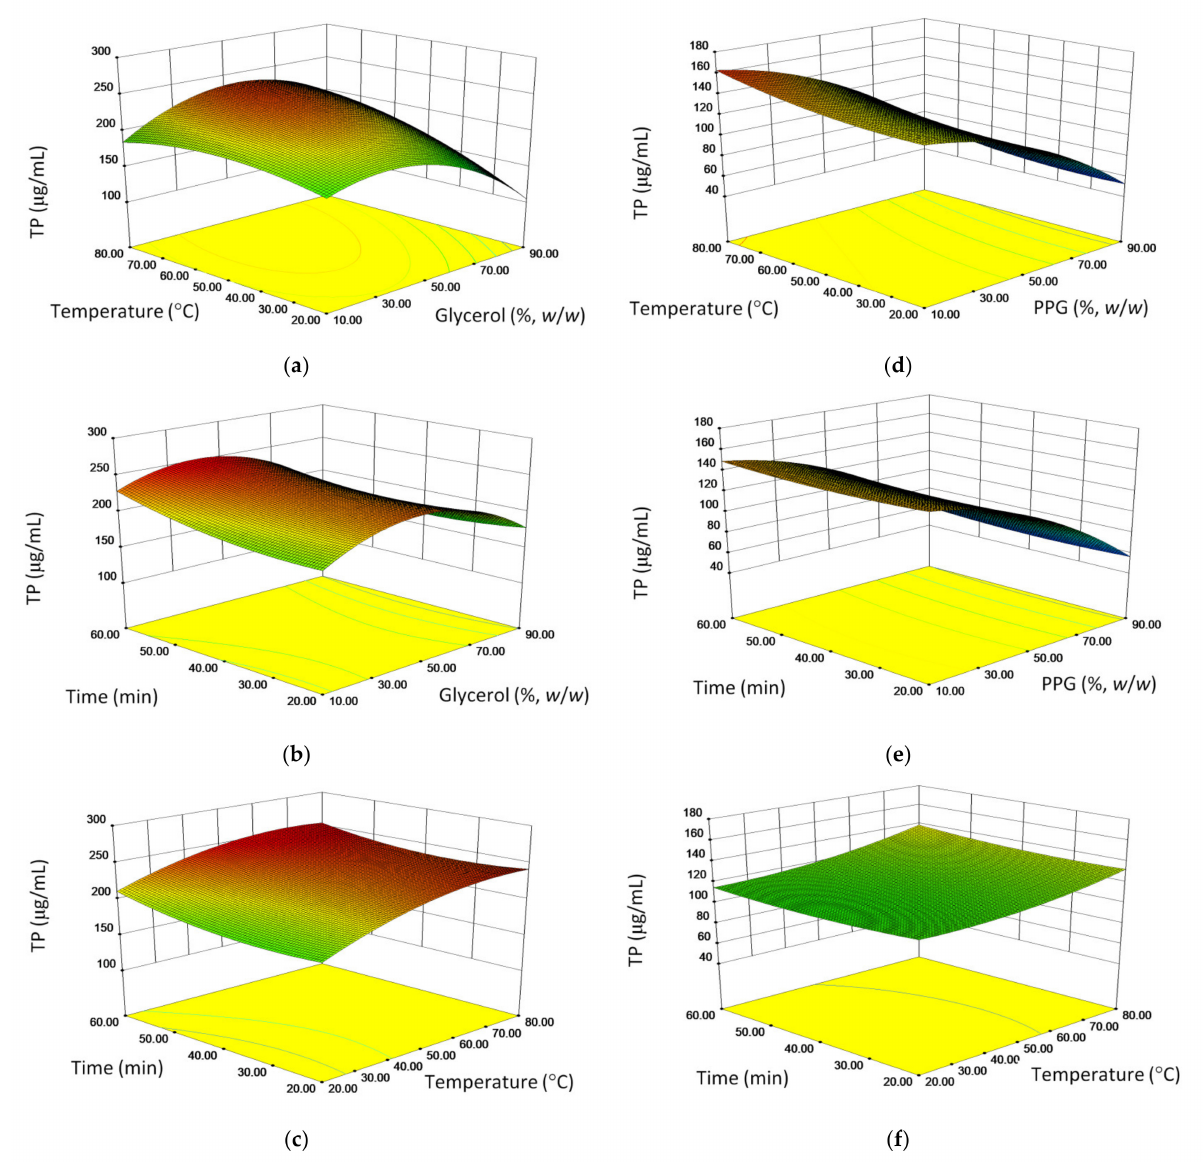
Figure 1. Influence of pairs of independent variables on phenolic content in two solvents: ( a–c ) glycerol; ( d–f ) polypropy- leneglycol